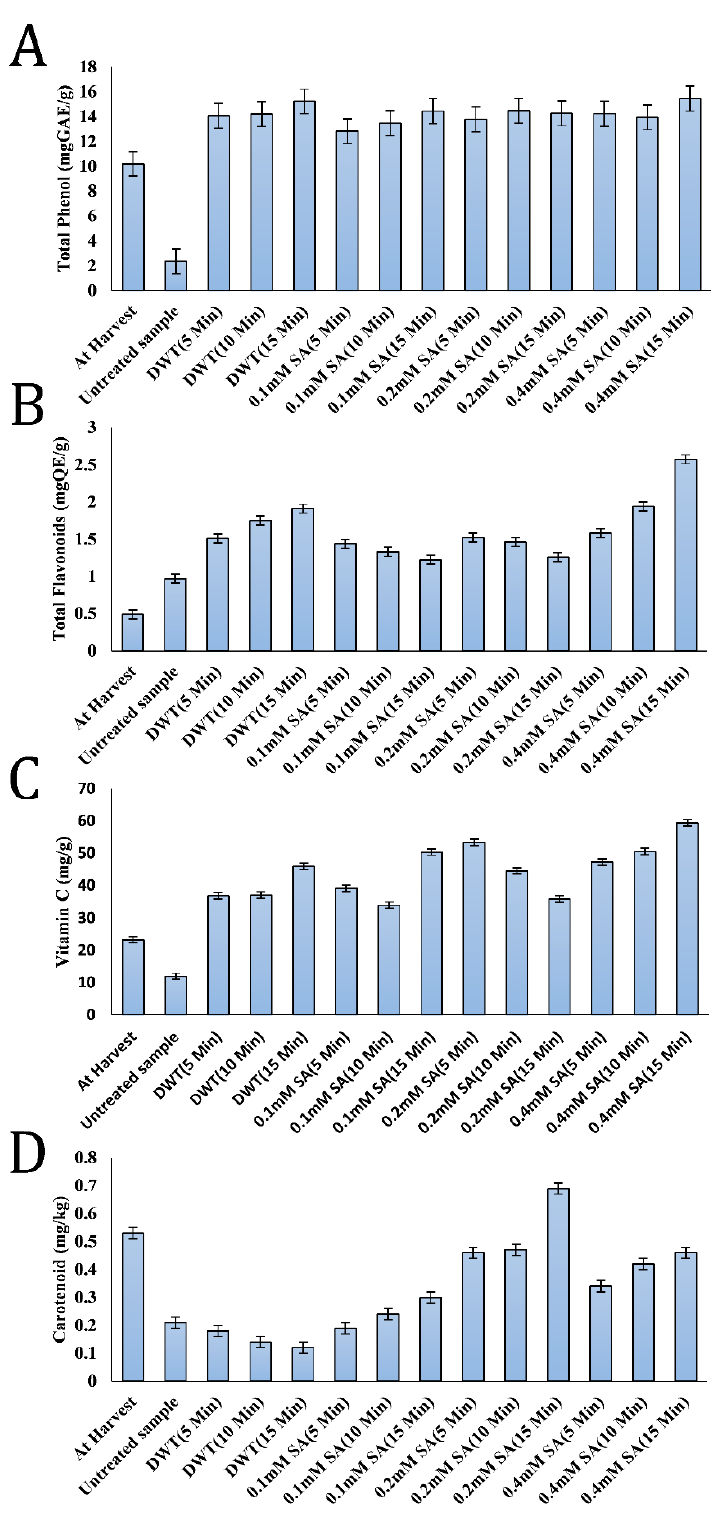
Figure 1. Salicylic acid (SA) treatment effect on total phenol (A), total flavonoid (B), ascorbic acid (C), and carotenoid (D) contents of African star apple ( Chrysophyllum albidum ) fruits after 15 days of storage at 28±2 °C and relative humidity of 90±5% for 15 days. Bars represent the mean ± standard error. GAE: Gallic Acid Equivalent. QE: Quercetin Equivalent. DWT: Distilled water-treated